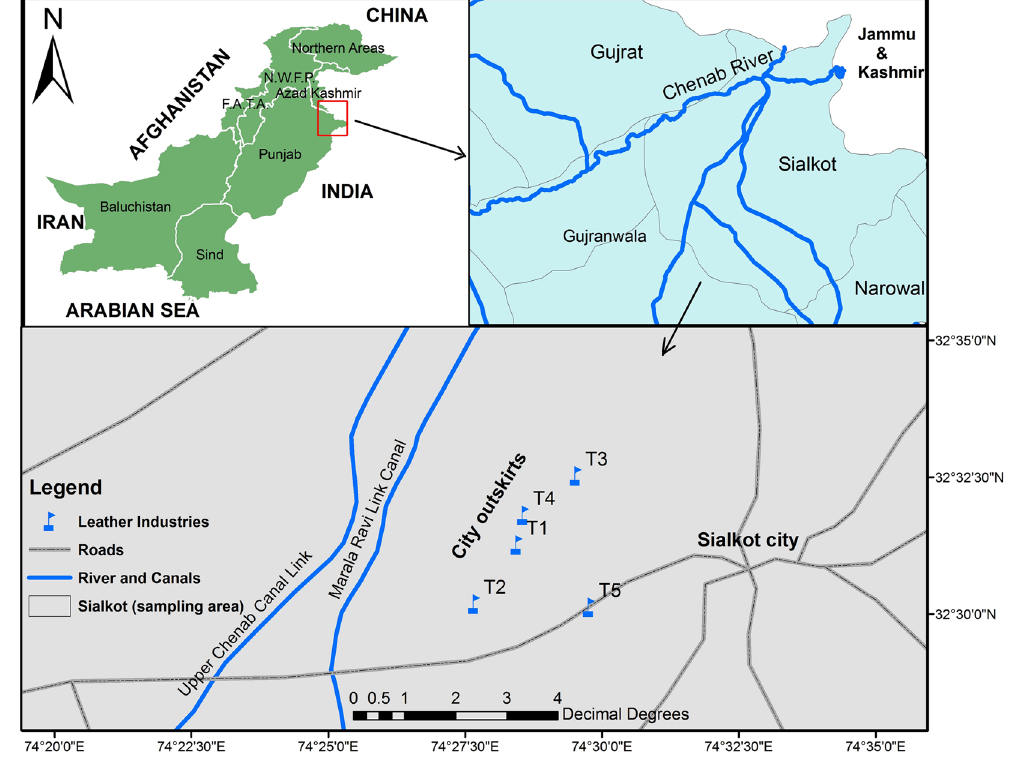
Figure 1. Map of the study area (Sialkot, Pakistan) developed using Arc GIS 9.3 (ESRI, USA)